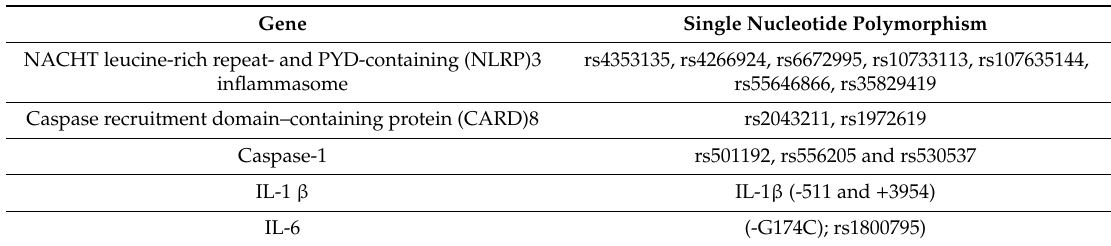
Table 1. Main gene variants (single nucleotide polymorphisms) related to the NLRP3-IL-1 β pathway. Gene Single Nucleotide Polymorphism NACHT leucine-rich repeat- and PYD-containing (NLRP)3